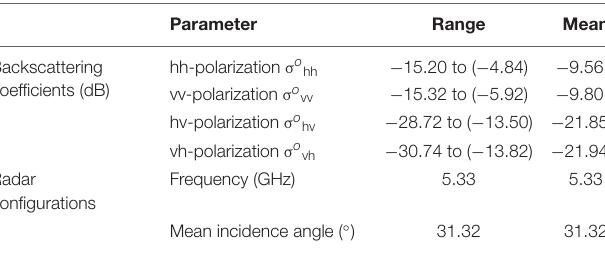
TABLE 1 | Radarsat-2 data description.